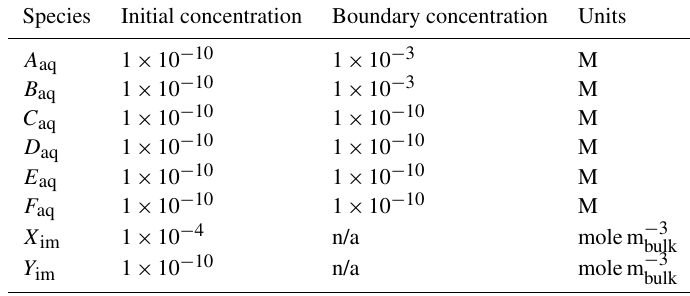
Table 5. Initial and boundary concentrations in the Reaction Sandbox Simple input